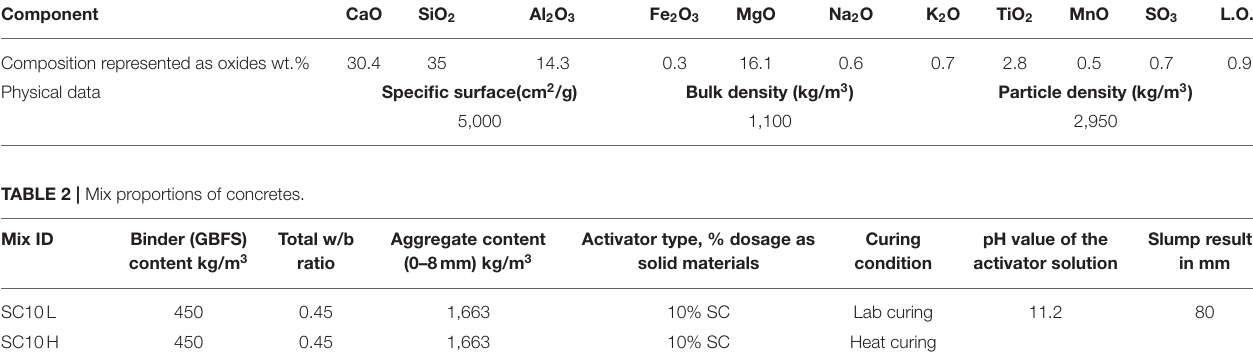
TABLE 1 | Details of GGBFS used in this work. Component Composition represented as oxides wt.%